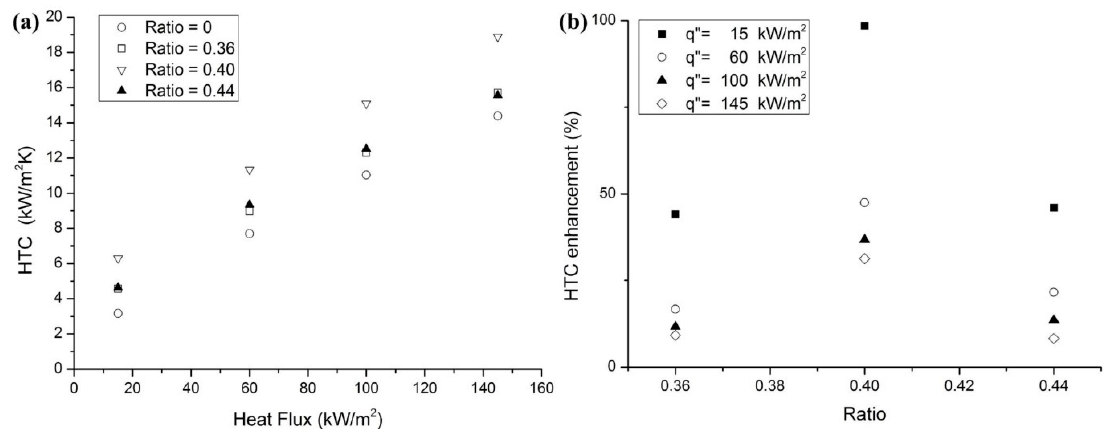
Figure 12. The effect of the pitch on ( a ) the HTC values for the specific heat fluxes and ( b ) the enhancement percentage in HTC with respect to the heat flux.